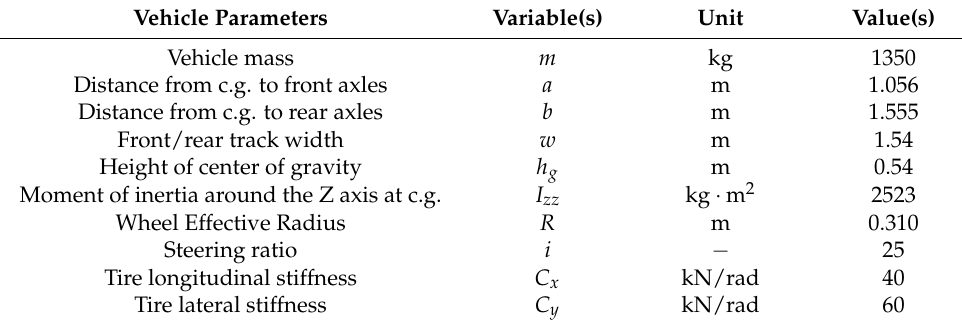
Table 1. Vehicle